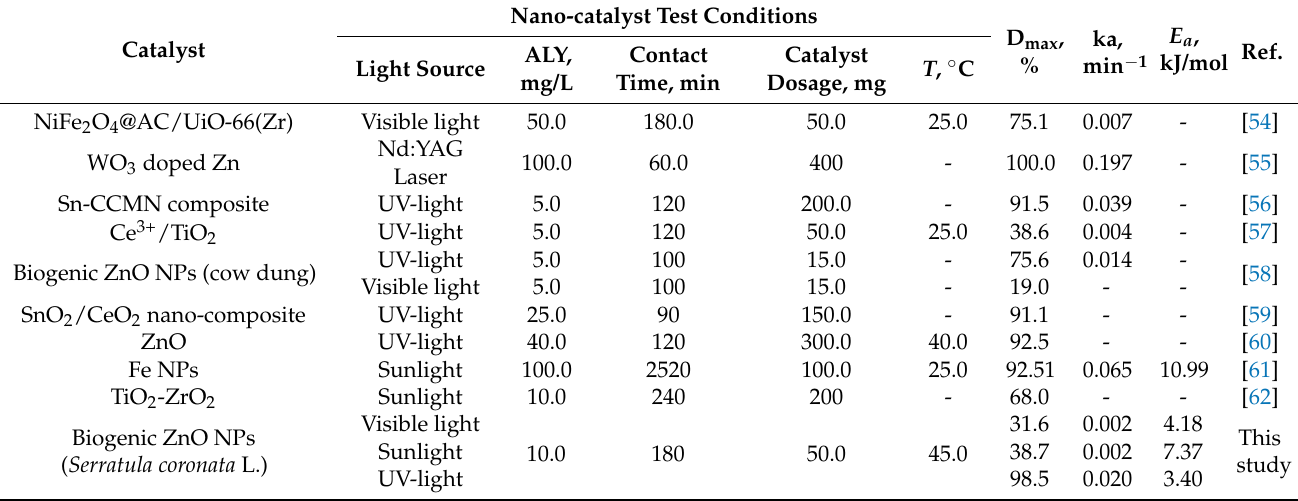
Table 2. Comparison of some properties and catalytic activities of different types of catalysts in the AY degradation